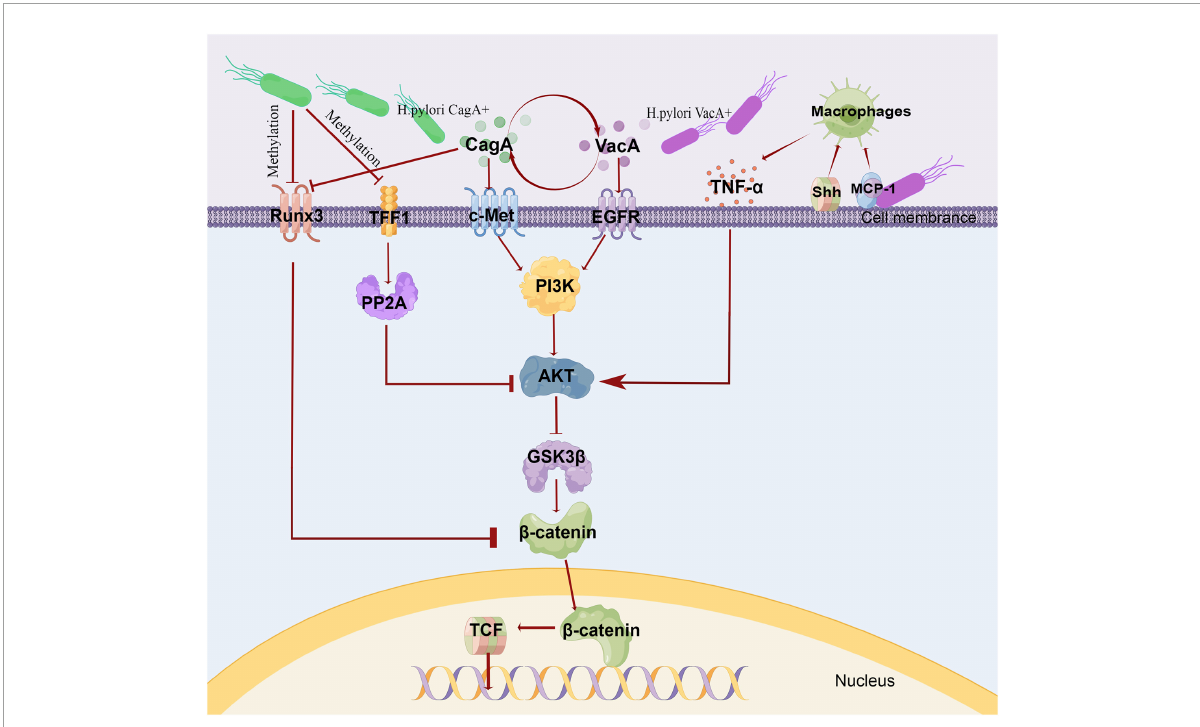
FIGURE1 Mechanism of gastric cancer induced by HP. The virulence of HP was expressed through various pathogenic markers, such as CagA, VacA. VacA and CagA could regulate each other. CagA induced c-Met phosphorylation, triggered PI3K/Akt signaling, and caused β -catenin accumulation. VacA induced EGFR phosphorylation and activated PI3K/Akt pathway. In HP infection, the intracellular pathway initiated by EGFR and c-Met converges to PI3K\/AKT-GSK3 β − − β catenin. Due to promoter methylation, the Wnt/ β -catenin repressor TFF1 and RUNX3 were often down-regulated, and RUNX3 was also associated with CagA. TFF1 inhibited Akt and GSK3 β phosphorylation through PP2A, and then reduced β -catenin nuclear translocation and TCF transcription activity. HP infection recruited macrophages via MCP-1or Shh. These macrophages produced pro-inflammatory cytokines, such as TNF- α ,which could activate Wnt/ β catenin via Akt-GSK3 β signaling in GC. This fig was made by Figdraw. CagA, cytotoxin-associated gene A; VacA, vacuolating cytotoxin A; TFF1, Trefoil factor 1; PP2A, protein phosphatase 2A; PI3K, phosphatidylinositol 3-kinase; MCP-1, monocyte chemoattractant protein-1; Shh, Sonic